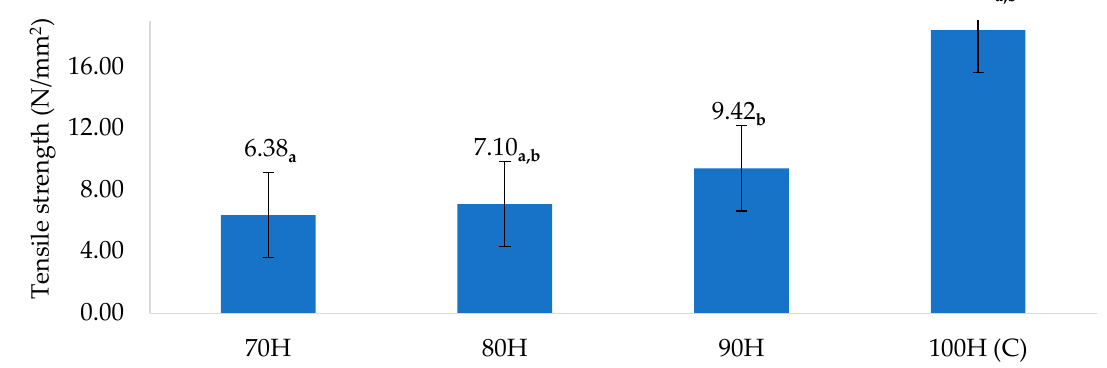
Figure 8. Average tensile strength of WPC at different ratio of HDPE and wood powder with dif- ferent alphabets (a, and b) displayed beside the average values show significant differences among the parameters